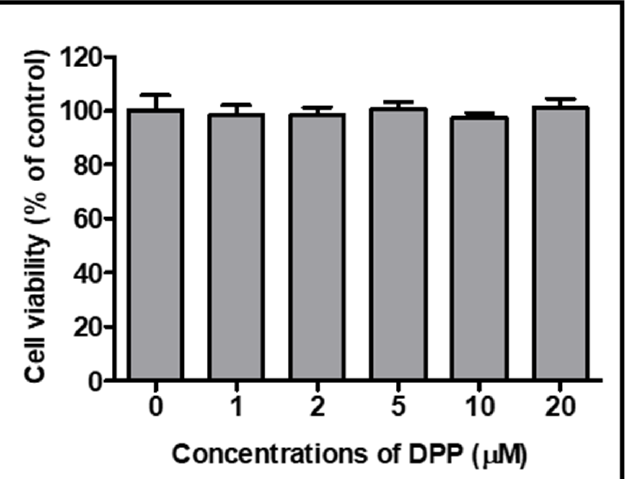
Figure 7. Cytotoxicity effect of DPP in Ac2F liver cells. Cells were cultured with the different concentrations of DPP (0–20 µM) for 24 h. Cell viability was assessed using the Ez-Cytox cell viability assay kit. Values are expressed as the mean ± SEM of three independent replications.